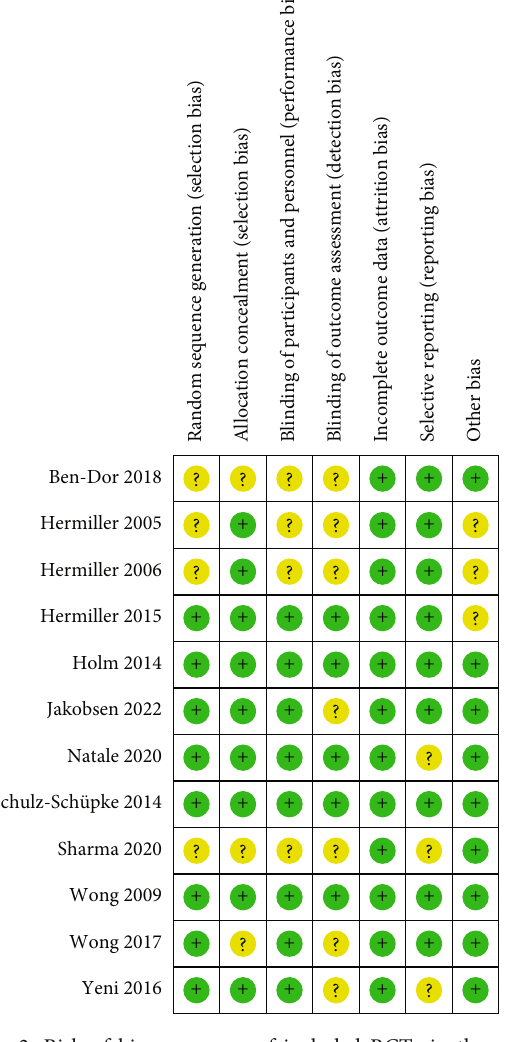
Table 2: Quality assessment of non-RCTs.